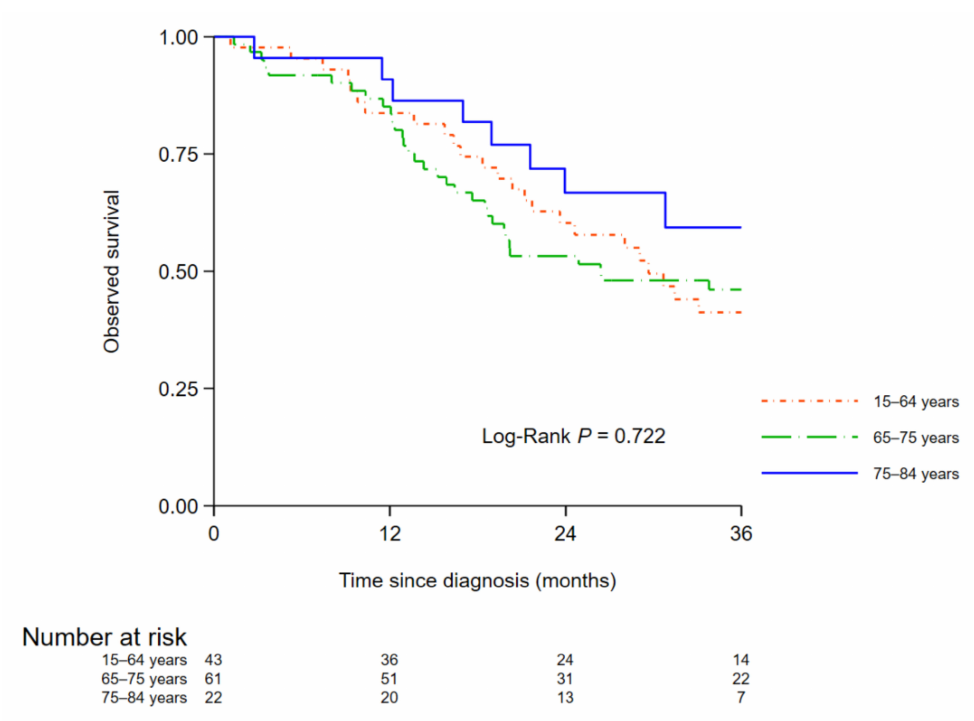
Figure 2. Three-year observed survival among patients with resected non-metastatic pancreatic cancer by